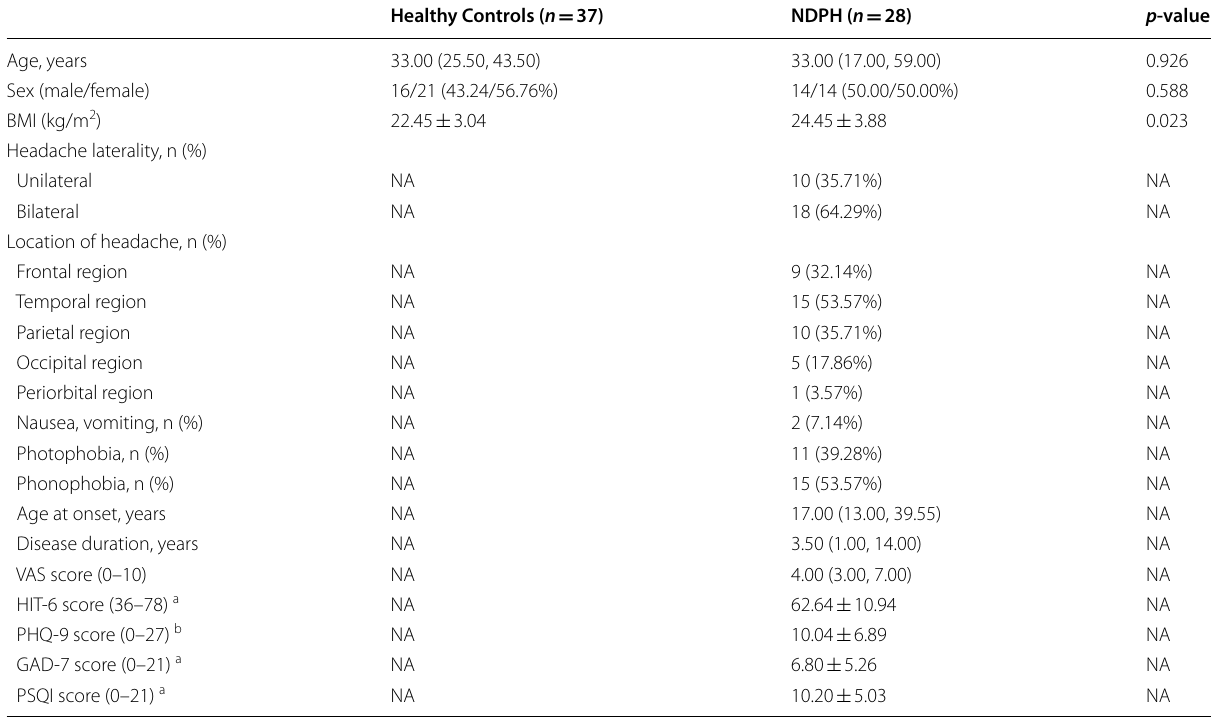
Table 1 Participants’ demographics and clinical